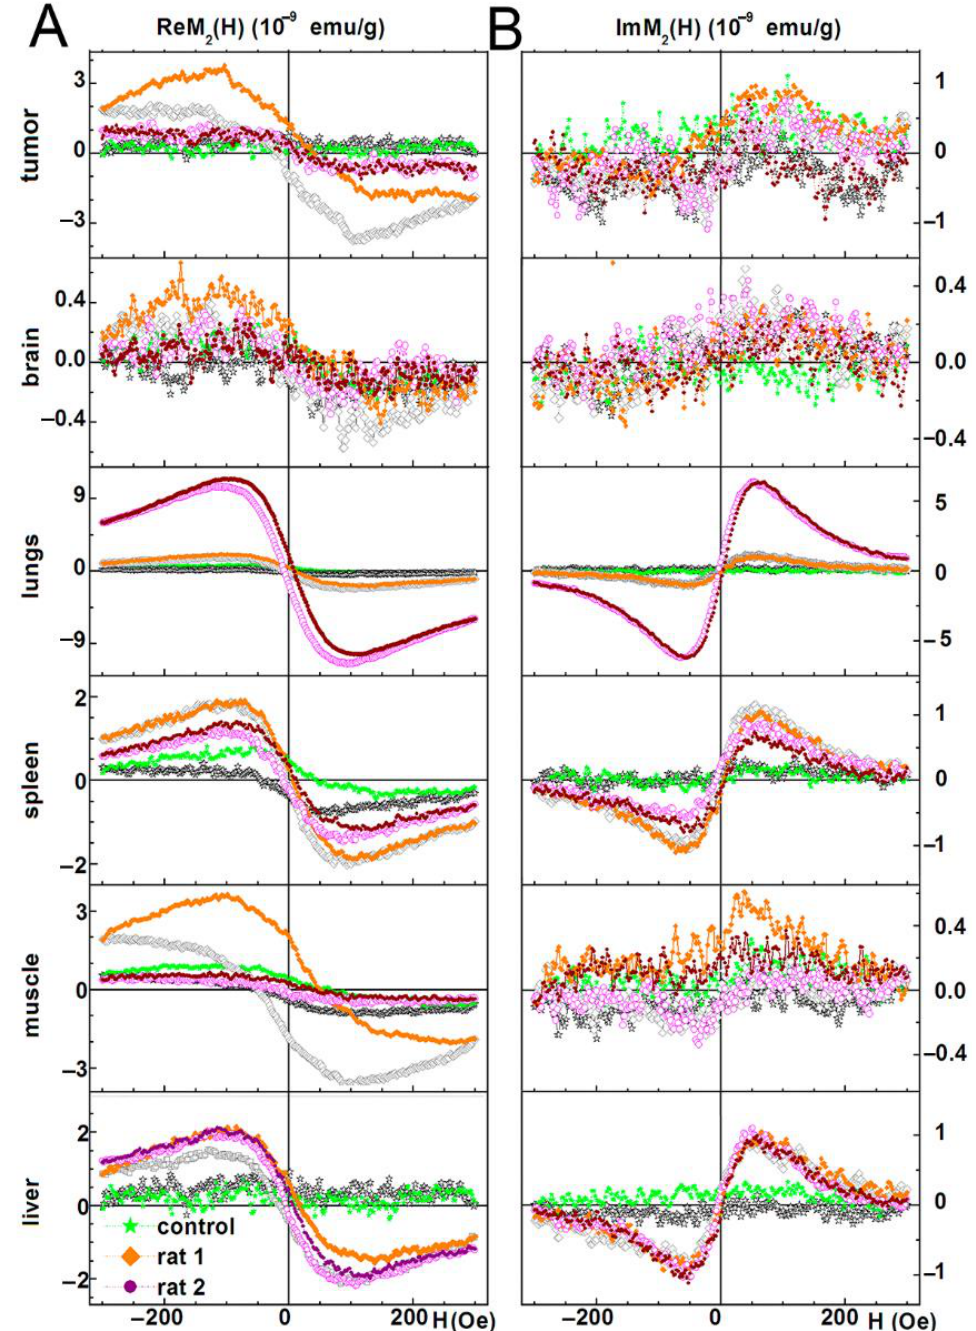
Figure 4. Real and imaginary parts of the nonlinear magnetic response as functions of the dc magnetic field direct (filled symbols) and reverse (open symbols) scans with F sc = 8 Hz are presented for liver, tumor, brain, lungs, spleen, and muscle extracted from two rats at 24 h following injection of SPIONs-labeled MSCs and one control rat without injection. Panels ( A ) and ( B ) present real and imaginary parts of M 2 response accordingly.